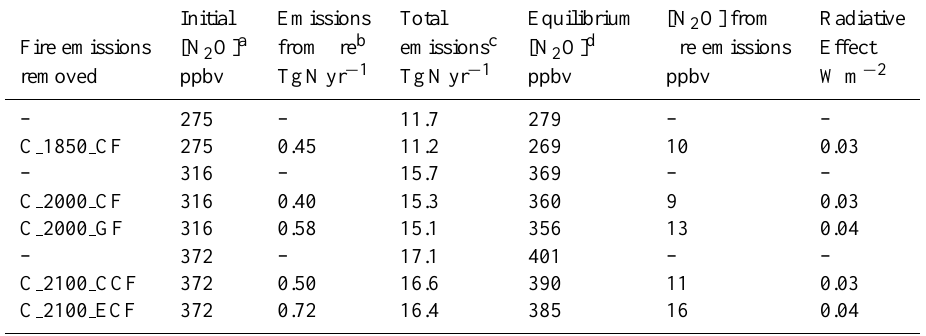
Table 4. Values used for the N 2 O box model equilibrium runs and the results of these runs. The “fire emissions removed” column uses the simulation names from Table 1 to indicate the year, fire emissions and atmospheric forcing used in the box model. Initial Emissions Total Equilibrium [N 2 O] from Fire emissions